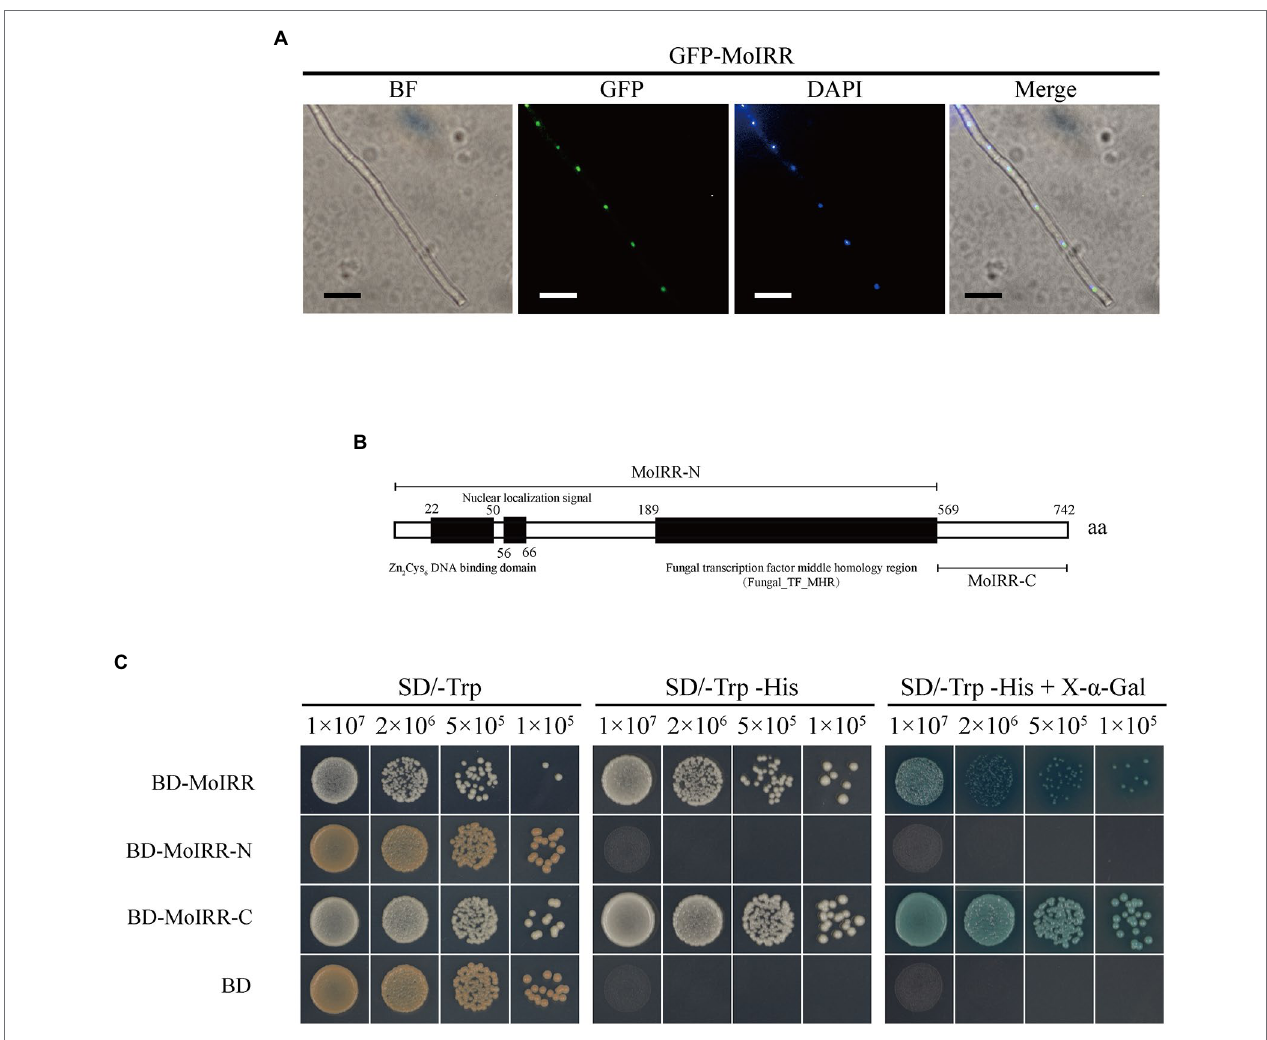
FIGURE 1 | MoIRR is translocated into the nucleus and has transcriptional activity. (A) Subcellular localization of GFP-MoIRR fusion in the hyphae. The image of GFP showed the localization of MoIRR (second panels). Image of DAPI staining showed the localization of nuclear (third panels). The merged image of GFP and DAPI staining showed that the GFP-MoIRR fluorescence signal was overlapped with DAPI nuclear localization (fourth panel). Image of BF was captured under bright field (first panel). Isolates containing GFP-MoIRR were grown in a PDB liquid medium at 27 ° C for 2 days before observation. Images were captured using an inverted fluorescence microscope. Bars were 20 μ m. (B) Schematic representation of Magnaporthe oryzae MoIRR. Prediction of Zn 2 Cys 6 DNA binding domain, nuclear localization signal, and Fungal_TF_MHR domains was indicated by the black box. MoIRR-N and MoIRR-C fragments were indicated by a line segment. MoIRR, MoIRR-N, and MoIRR-C were cloned and inserted into vector pGBKT7. Then, plasmids were transformed into yeast cells for the transcriptional activation experiment. Domains indicted in the schematic were predicted with Conserved Domain Database in NCBI